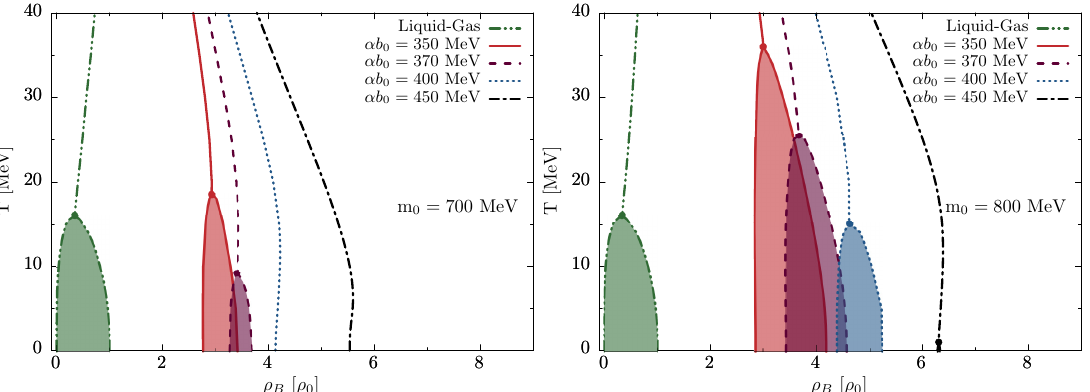
Figure 5. The Low-temperature part of phase diagram in the ( T , ρ B ) -plane for isospin-symmetric matter obtained in the hybrid QMN model for m 0 = 700 MeV ( left ) and m 0 = 800 MeV ( right ). The curves indicate phase boundaries and the colored areas correspond to the density jump associated with the first-order phase transition. The green dashed-doubly-dotted curve corresponds to the liquid–gas phase transition common for all α b 0 . The circles indicate critical points on the transition lines above which the first-order transition turns into a crossover. For m 0 = 700 MeV, no critical point is shown for the cases with α b 0 = 400 MeV and α b 0 = 450 MeV, where the chiral phase transition is a smooth crossover at all